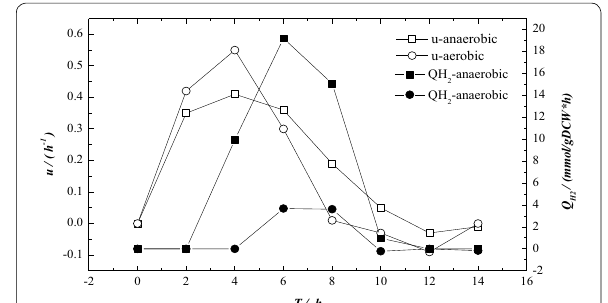
Fig. 7 The relationship with μ and Q H2 during EB-06 biohydrogen production process under aerobic and anaerobic conditions